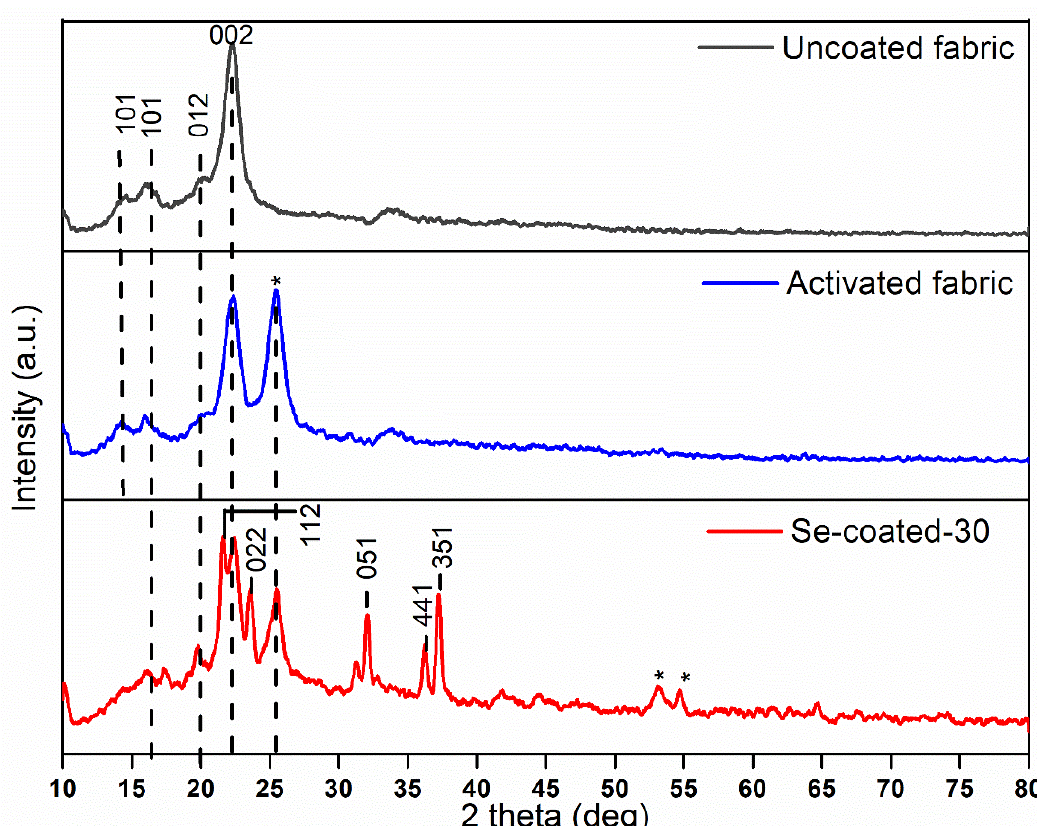
Figure 7. XRD pattern of Uncoated, Activated, and Se-coated-30 fabric samples in the 2 θ range of 10° – 80° were compared as